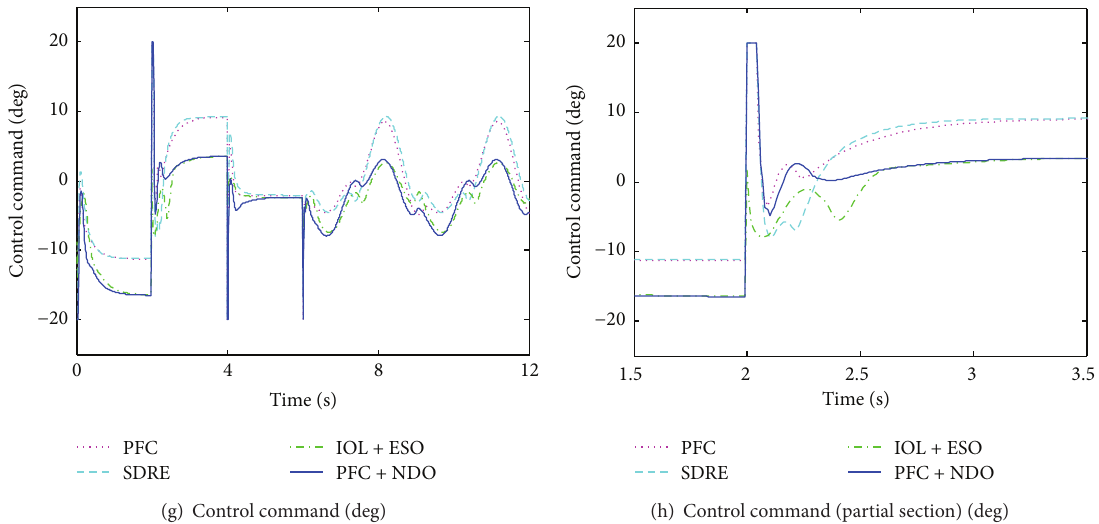
Figure 3: Simulation responses under the four controllers and the estimate performance of the NDO in the case of negative uncertainties and